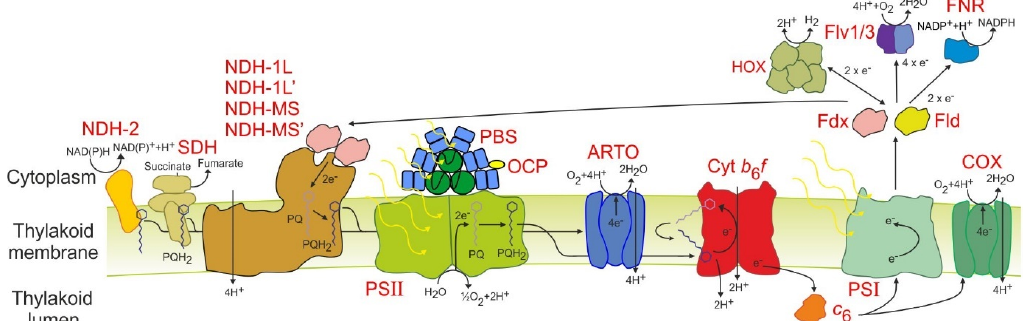
Figure 2. Schematic diagram of the proposed PCC 11901 electron transport chain network. NDH-